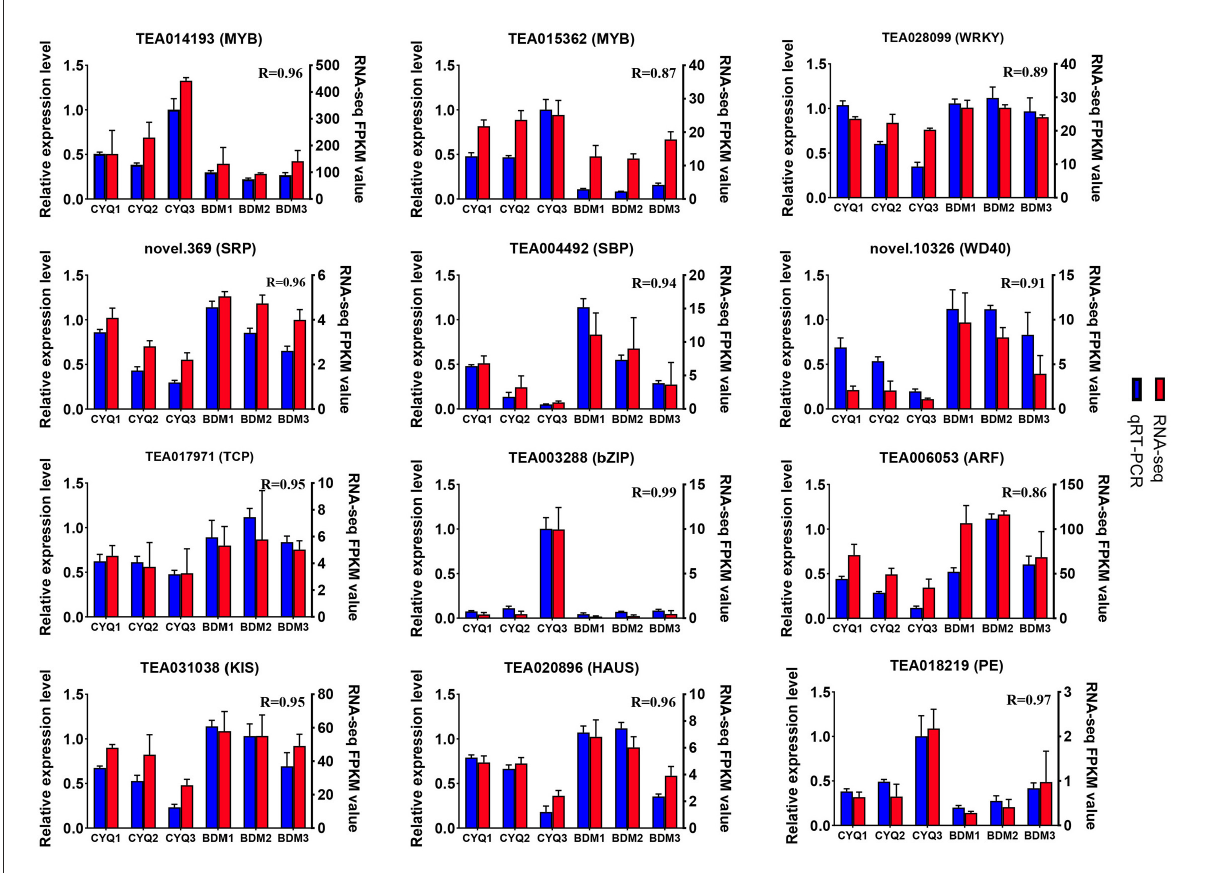
FIGURE3 Quantitative RT-PCR validation. Twelve DEGs were selected for qRT-PCR detection. Error bars indicated the standard deviation of the three independent replicates.